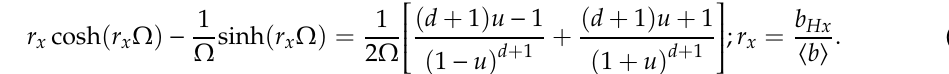
Figure 6. Ratio 𝑟 (cid:3051) = 𝑏 (cid:3009)(cid:3051) 〈𝑏〉⁄ versus dimensionless pressure gradient Ω for different values of the shape parameter 𝑑 .